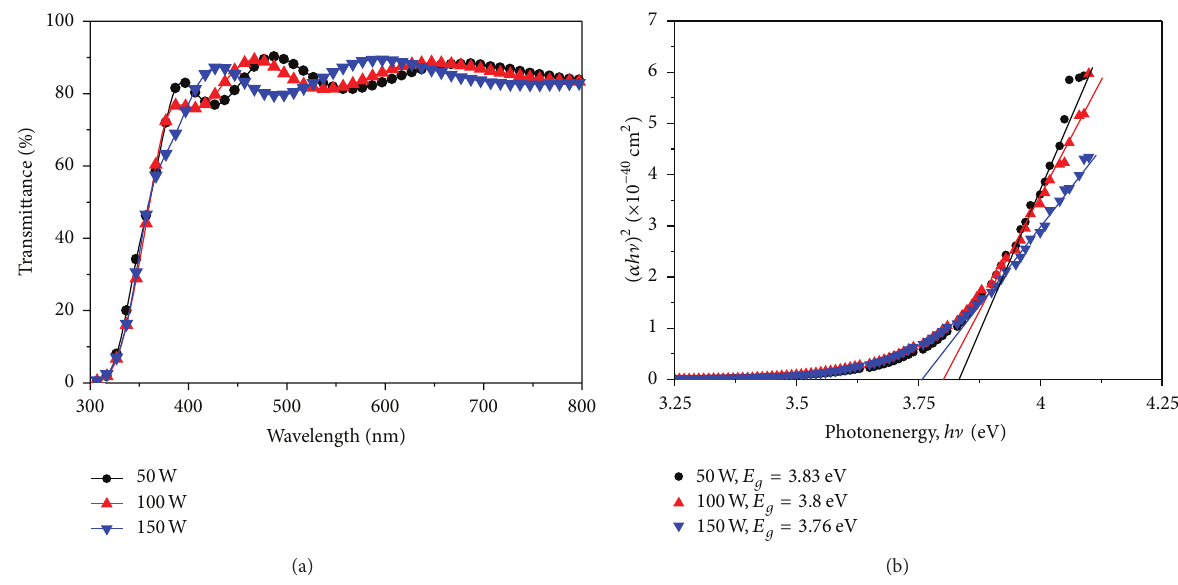
Figure 4: (a) Transmittance and (b) (𝛼ℎ ] ) 2 versus ℎ ] - 𝐸 𝑔 plots of the GZO thin films as a function of deposition power.